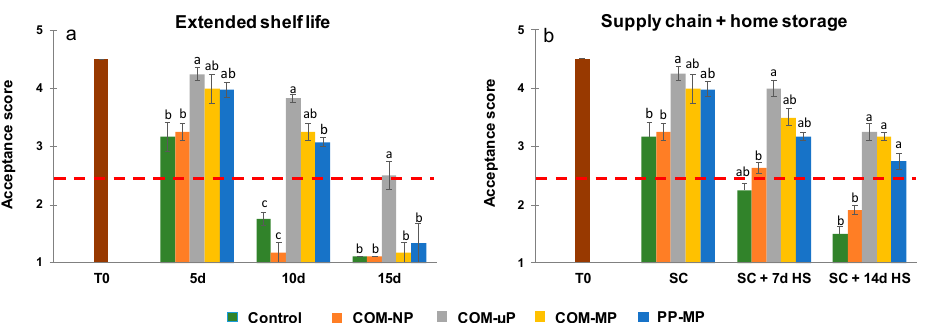
Figure 8. Acceptance scores of cucumbers kept in the different types of packaging. Measurements were taken during continuous storage under shelf conditions at 22 ◦ C (Extended shelf life) and after the simulated farm-to-fork supply-chain treatment (2 days at 15 ◦ C + 2 days at 22 ◦ C) plus 1 or 2 weeks of refrigerated home storage at 4 ◦ C (Supply chain + home storage). Figures ( a ) and ( b ) represent overall acceptance scores after extended shelf life and farm-to-fork supply-chain conditions, respec- tively. Data are means ± SE of 3 replications. The red dashed line indicates the minimum acceptance threshold of 2.5. Different letters indicate significant differences at p ≤ 0.05.